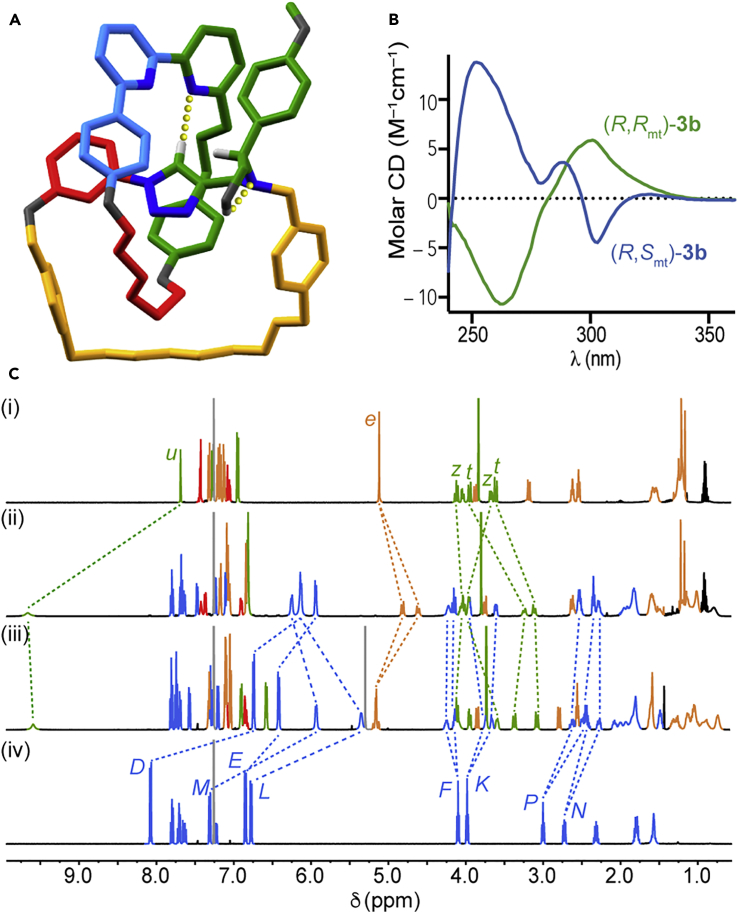
Characterization of Catenanes 3b(A) Solid-state structure of major diastereomer (R,Smt)-3b35 with selected intercomponent interactions highlighted (selected distances [Å]: Hu···N = 2.35, OH···N = 2.28).(B) CD spectra of (35 μM in CHCl3) (R,Smt)-3b and (R,Rmt)-3b.(C) Partial stacked 1H NMR spectra (500 MHz, 298 K, CDCl3) of (i) the corresponding non-interlocked triazole macrocycle derived from (S)-1, (ii) catenane (R,Rmt)-3b, (iii) catenane (R,Smt)-3b, and (iv) macrocycle 2b. Selected signals are assigned and color coded (see Scheme 1). Signals corresponding to macrocycle 2b are all shown in blue for clarity.